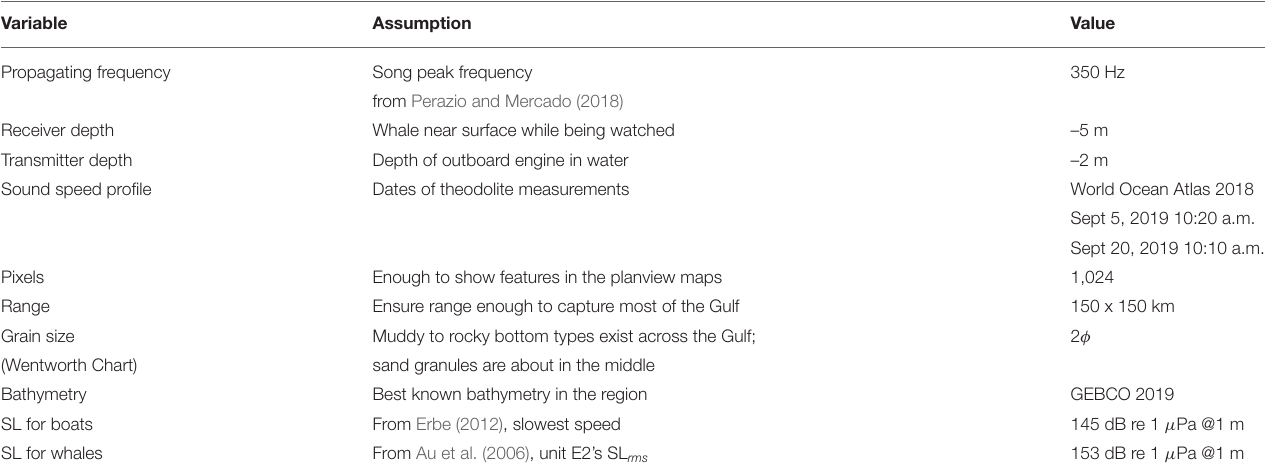
TABLE 1 | Inputs to the PE model for Gulf of Tribugá